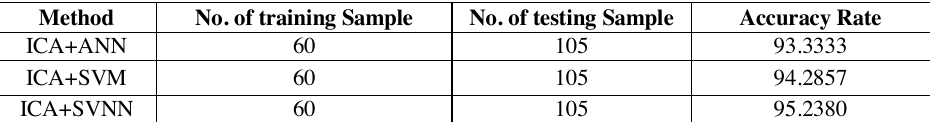
Table 1. The experiments result on Yale